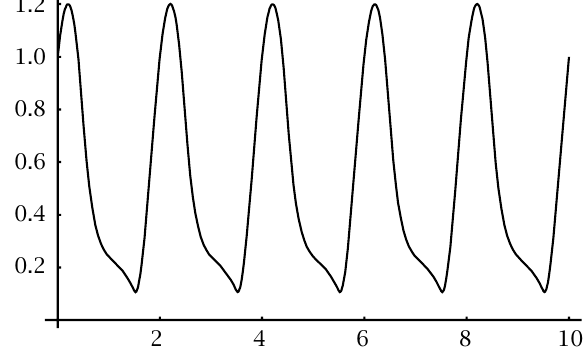
Figure 6.4 . T j (t) for b(t) = b cos (πt) , b = 3, d j = 3 . 656.